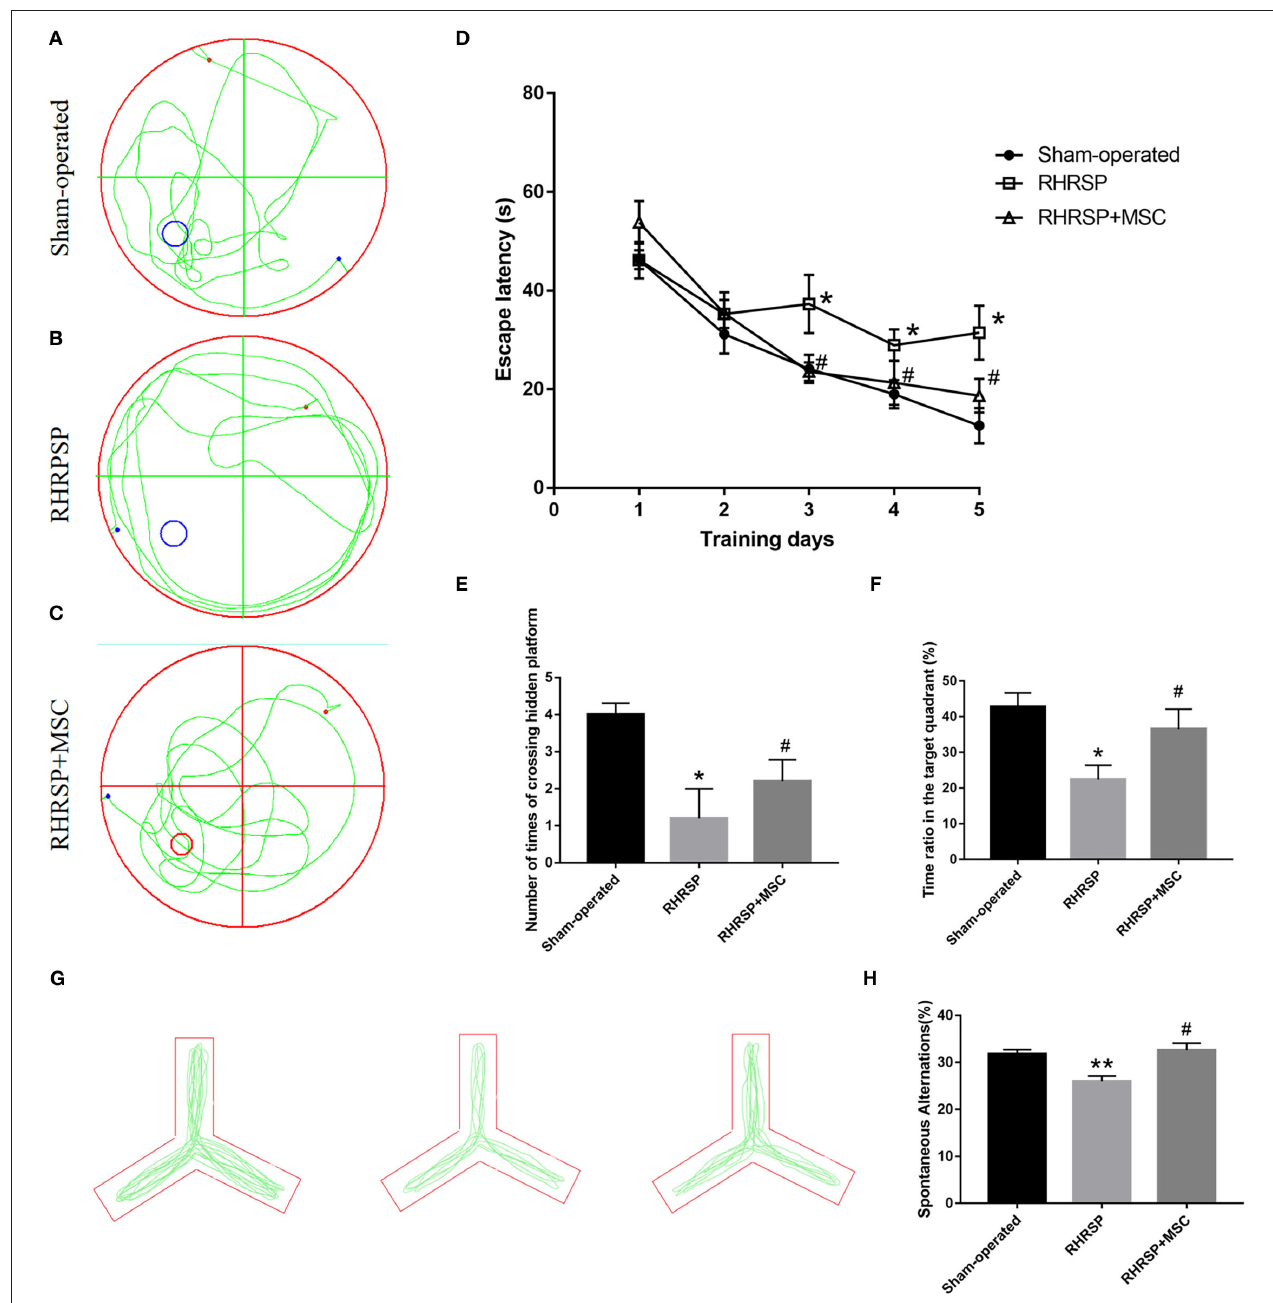
FIGURE 2 | MSCs improved memory, learning, and cognitive behavior in RHRSP rats. (A–C) the representative trajectories of spatial probe test at the last day. (D) mean escape latency to reach the platform during training days. (E,F) the number of times crossing the hidden platform and the time spent in the target quadrant where the platform was previously present. (G) the representative trajectories spontaneous alteration behaviors of Y maze. (H) the spontaneous alternations of Y maze (* P < 0.05, ** P < 0.01, vs. Sham-operated group; # P < 0.05, vs. RHRSP group; n = 6/group).